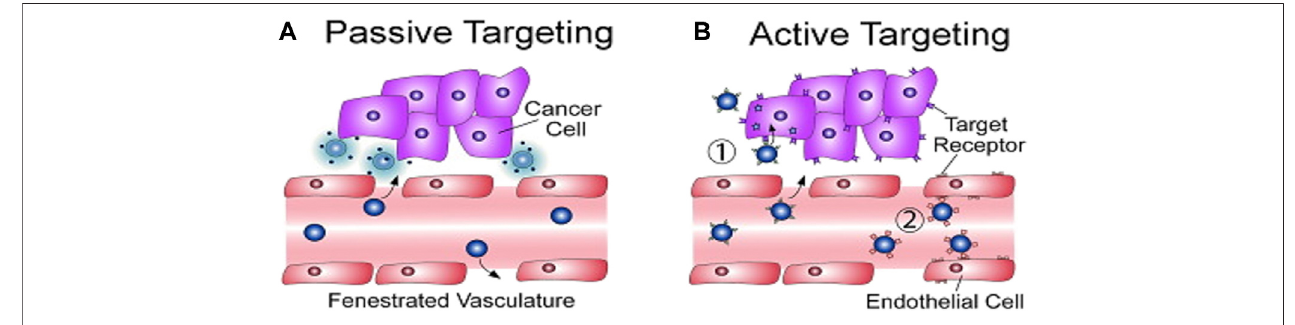
FIGURE 10 | Schematic comparison between (A) Passive and (B) Active Targeting ( fi gure adapted from reference (Wicki et al.,